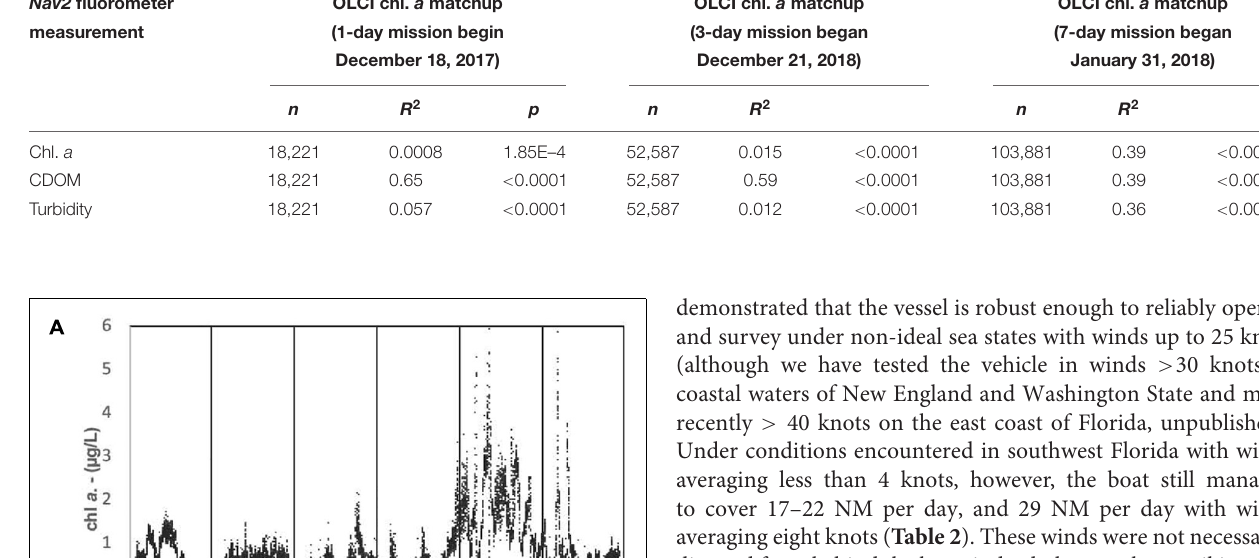
TABLE 3 | Sentinel3 satellite (OLCI) chl. a data matchup statistics revealed from linear regression analysis when correlated to each of the parameters measured using in situ fluorometry by the Nav2 boat. Nav2 fluorometer